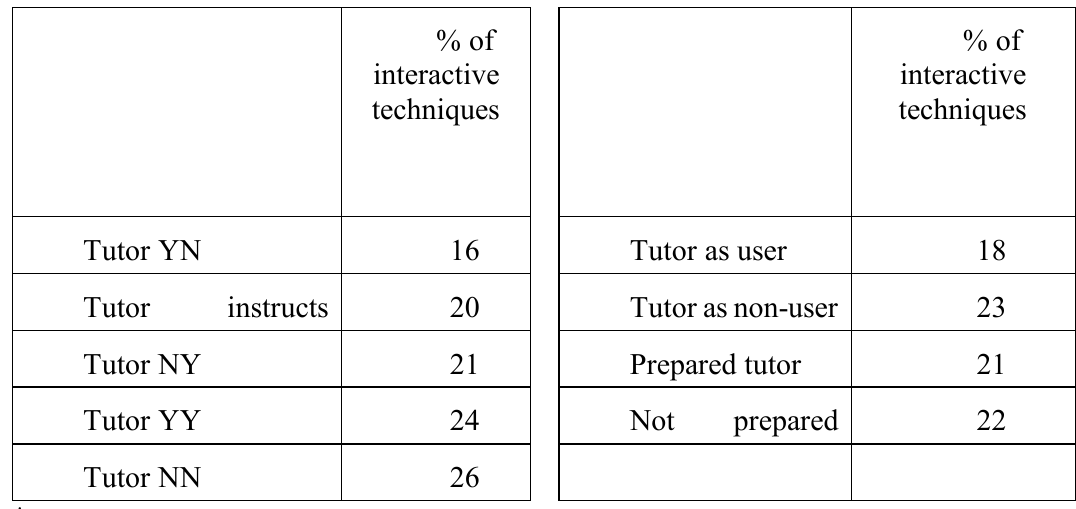
Table 4 . Proportion of interactive techniques of all the techniques used in all the turns per tutor